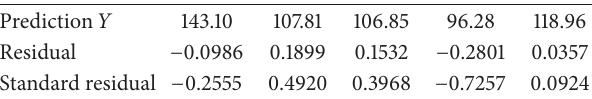
Table 10: Value of residual and standard residual of formula (4). Prediction